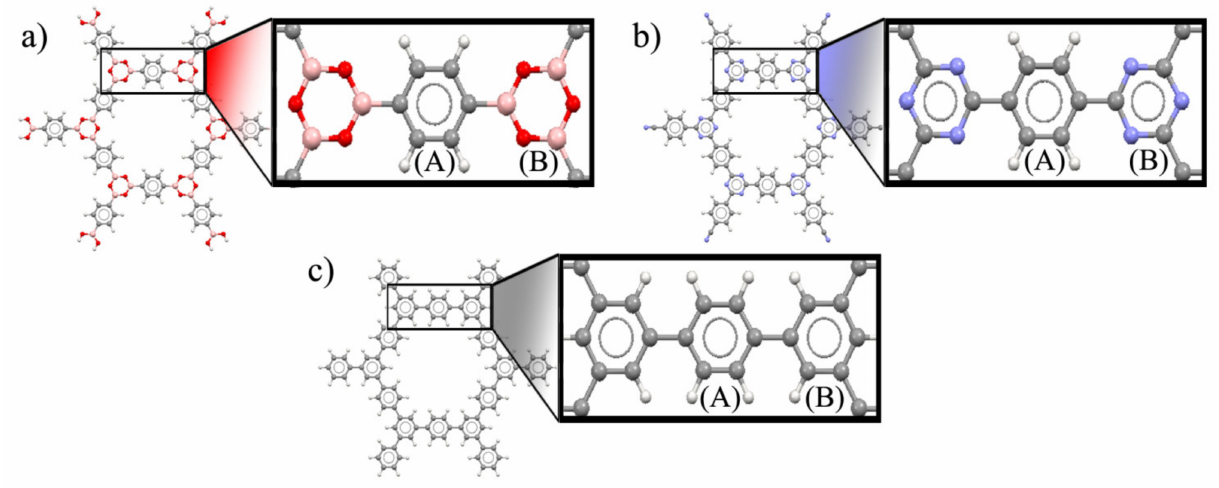
Figure 2. Optimized structure of ( a ) COF-1, ( b ) CTF-1 and ( c ) TPG.